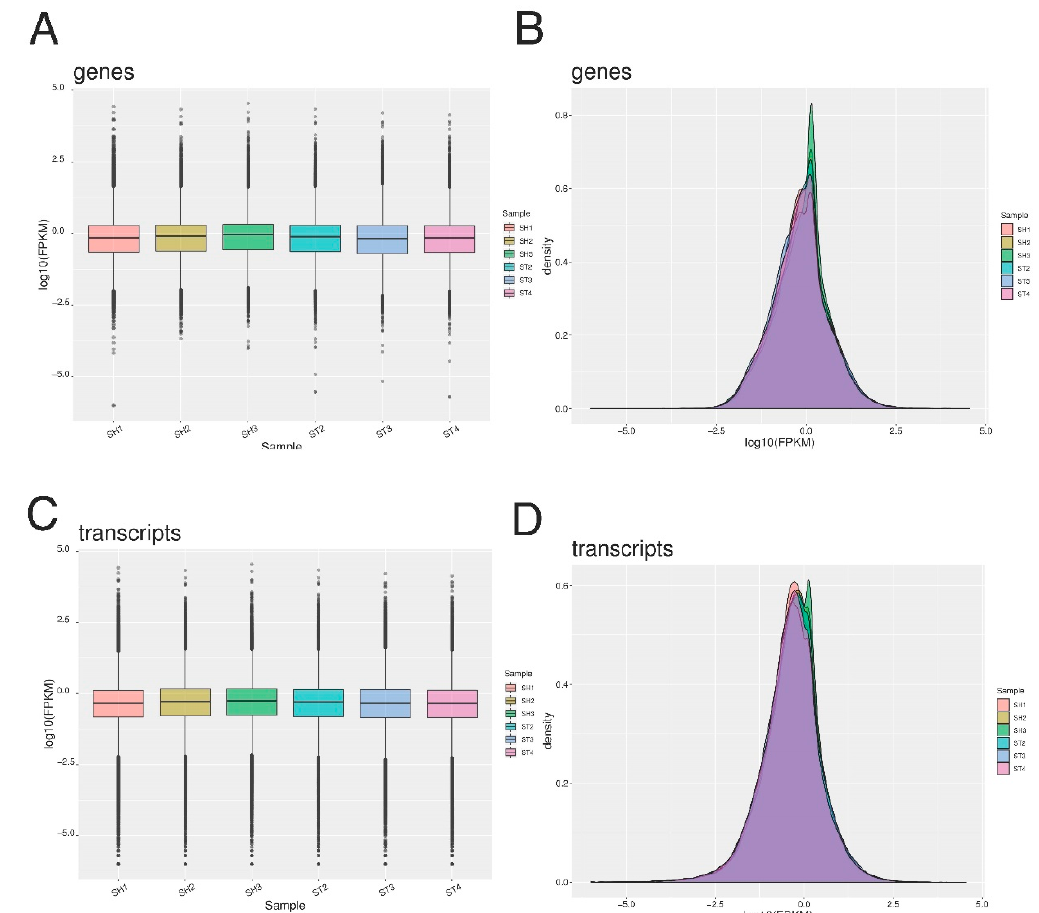
Figure 4. Log10 transformation of FPKM analysis for genes as box plot (4a), and density plot (4b), as well as for transcripts as box plot (4c), and density plot (4d).